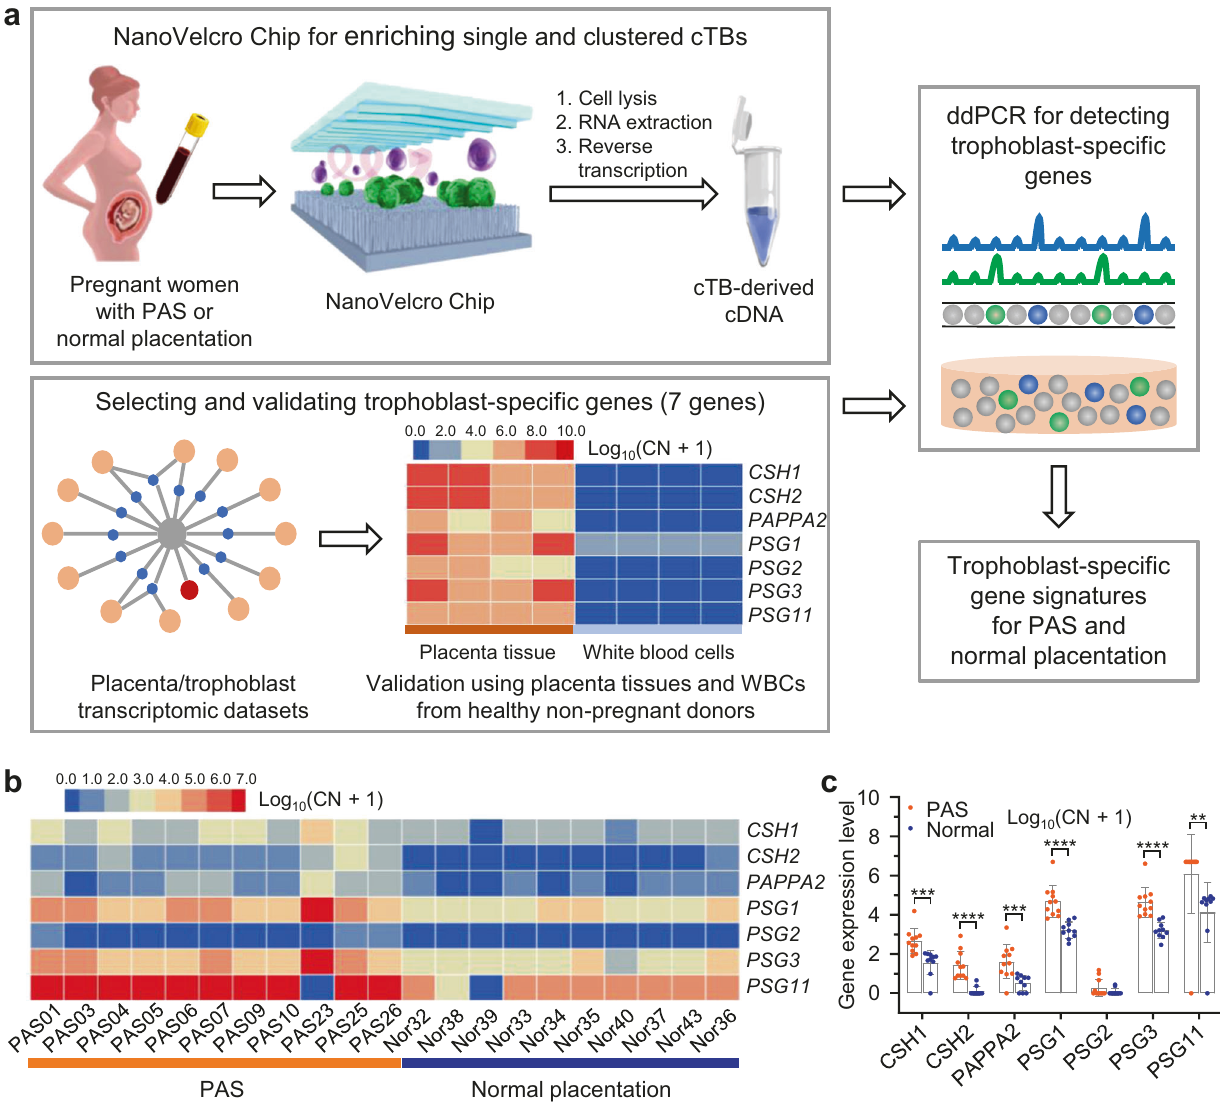
Fig. 7 RT-ddPCR assay for detection of trophoblast-speci fi c genes in the cTBs captured by NanoVelcro Chips con fi rming trophoblast cells of